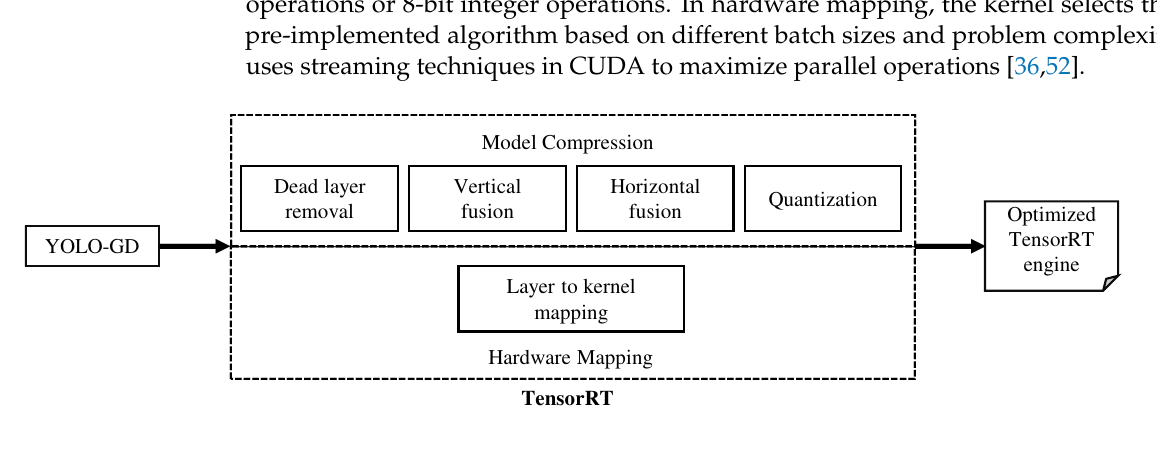
Figure 5. TensorRT optimization steps.